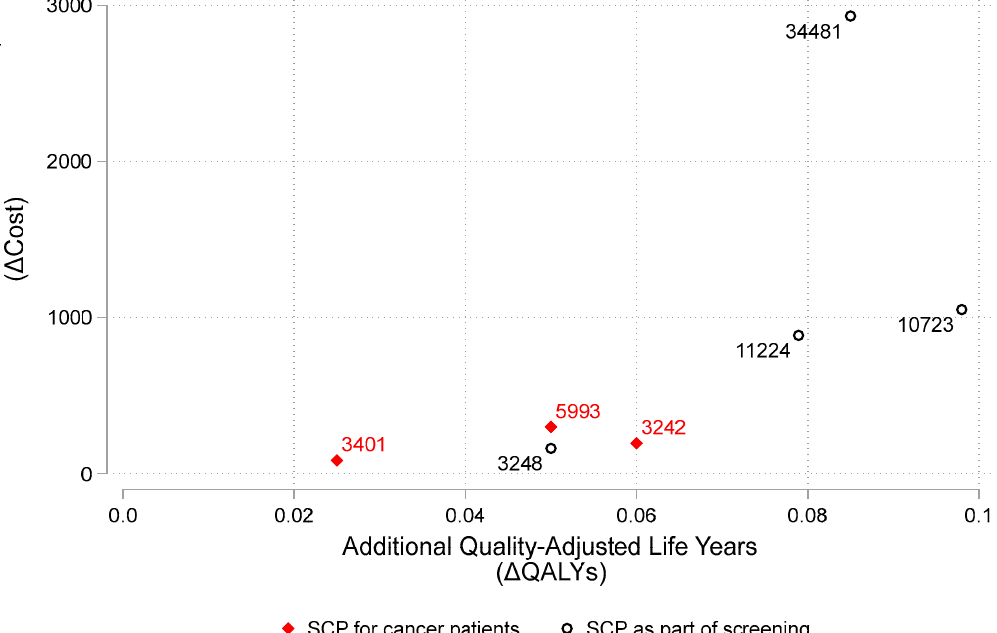
Figure 4. Cost-effectiveness plane. Note: Figure 4 illustrates results reported in the peer-reviewed scientific literature on smoking cessation programs (SCPs) estimating the extra quality-adjusted life years ( ∆ QALYs) and the extra costs in 2022 Canadian dollars ( ∆ C). The ratio ∆ C/ ∆ E (i.e., the incremental cost-effectiveness ratio or ICER) is shown as the label for each point. Diamond points (i.e., ♦ ) show results from studies of SCPs for cancer patients while circular points (i.e., ○ ) show study results for SCPs supplementing cancer screening programs.